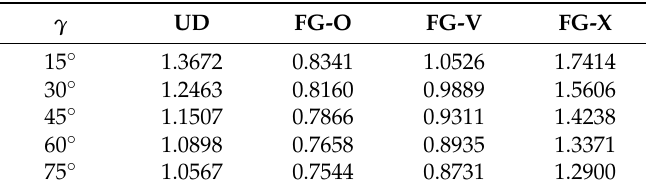
Table 3. Influences of semi-vertex angle γ on the non-dimensional frequency of the CNTRC truncated conical shells.